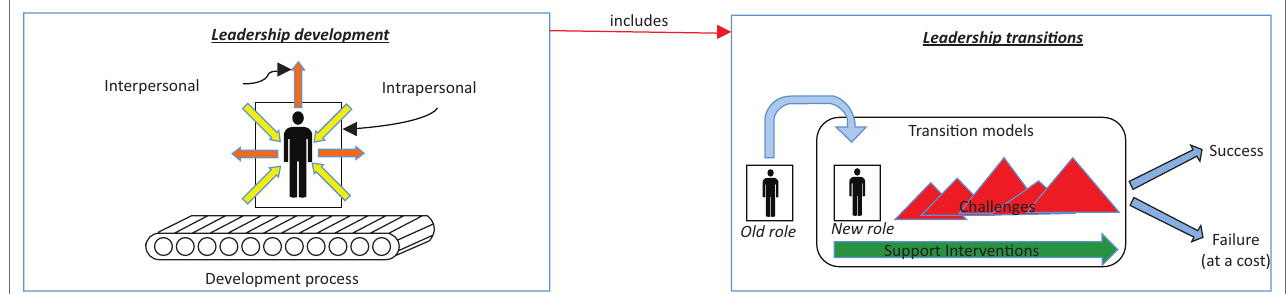
FIGURE 1: Theoretical underpinnings of this